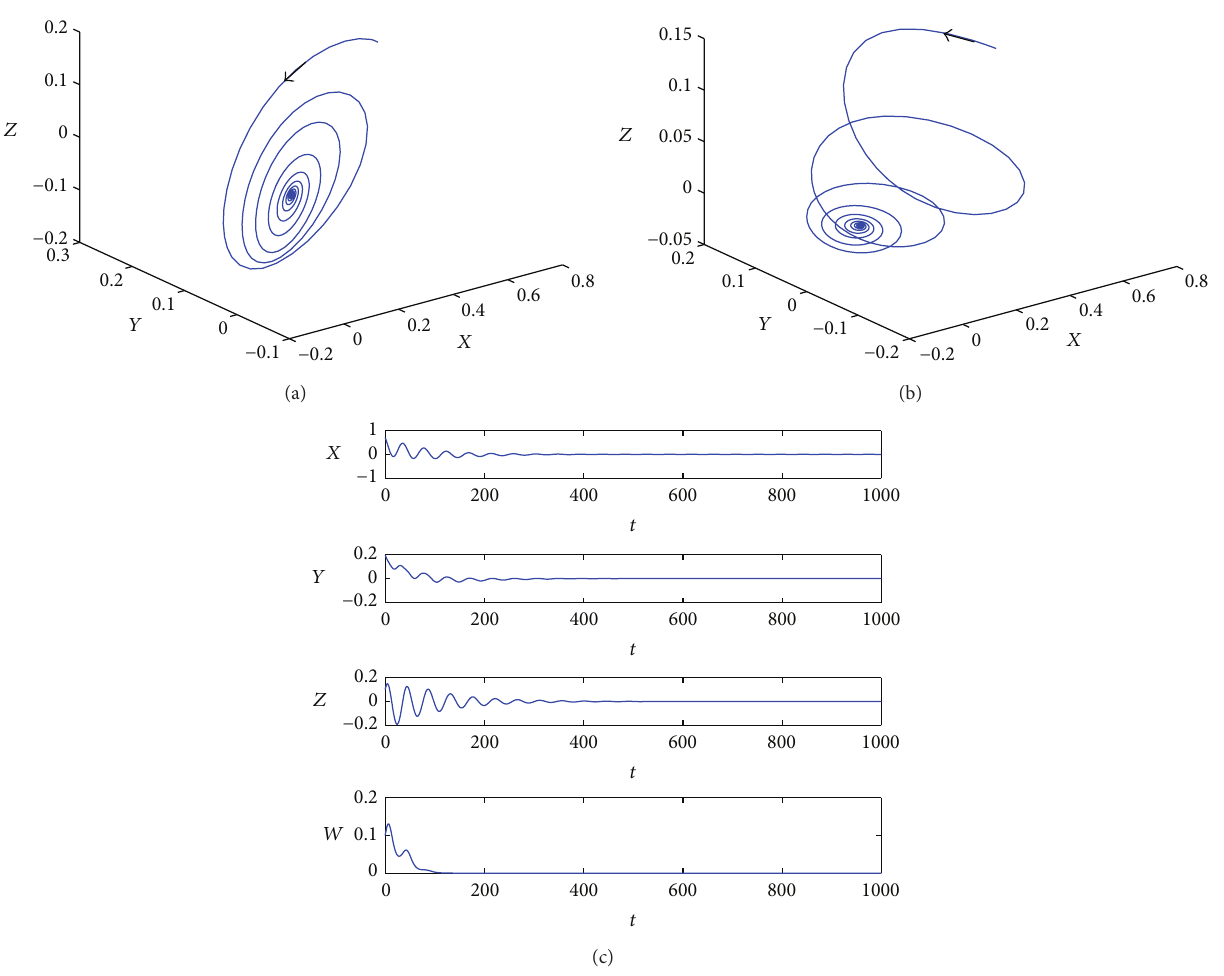
Figure 3: A stable focus point of system (1): (a) a 3D view ( 𝑋 - 𝑌 - 𝑍 ), (b) a 3D view ( 𝑋 - 𝑍 - 𝑊 ), and (c) the time series of 𝑋(𝑡),𝑌(𝑡),𝑍(𝑡),𝑊(𝑡)